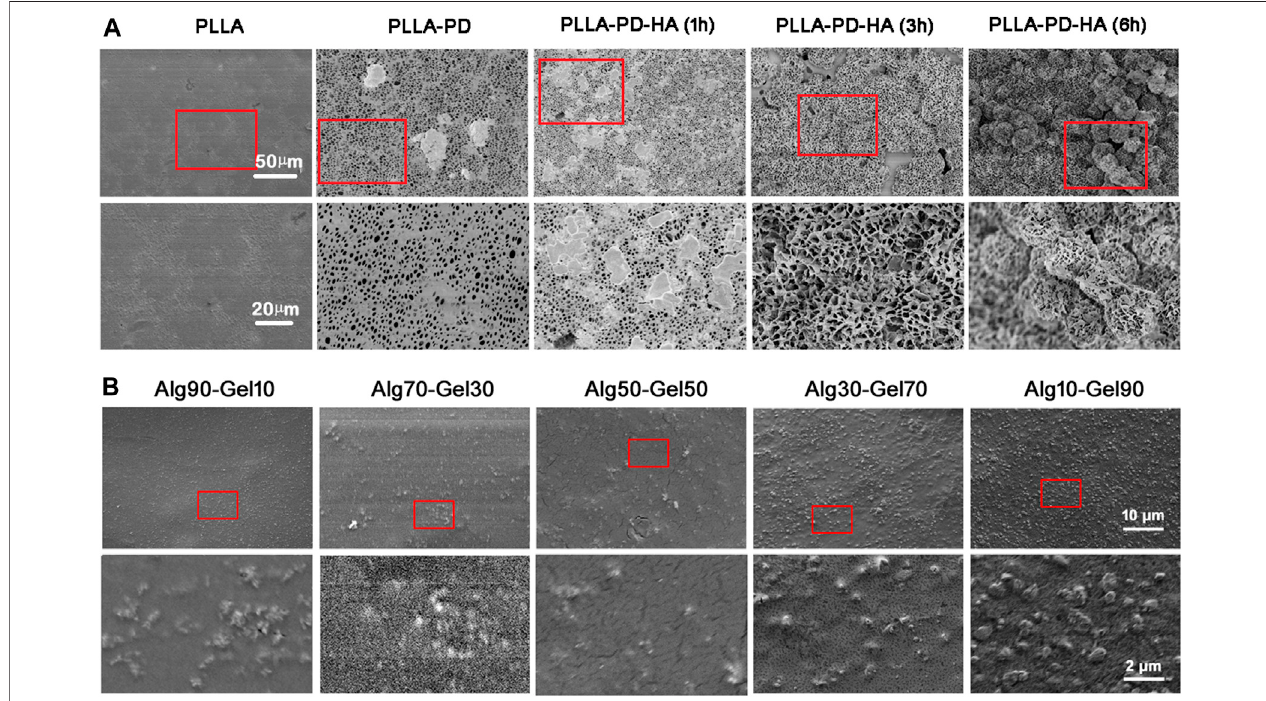
FIGURE 1 | SEM images of (A) synthesis ofcomposite coatings: PLLA, PLLA-PD, PLLA-PD-HA (1 h), PLLA-PD-HA (3 h), and PLLA-PD-HA (6 h) and (B) different ratios of alginate and GelMA. SEM, scanning electron microscopy; PLLA, poly-L-lactic acid; PD, polydopamine; HA, hydroxyapatite; GelMA, gelatin methacrylate.